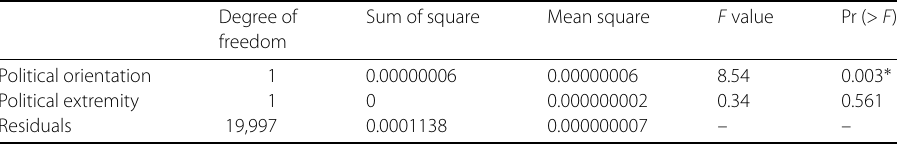
Table 19 Multi-group mean comparisons of obedience to authority using Tukey’s HSD test Mean 95% Confidence interval Adjusted difference P-valueLower Upper bound bound lwe-lw –0.0005 –0.0009 –0.0001 0.0051 ∗ rw-lw 0.0003 –0.0001 0.0007 0.18 rwe-lw 0.0012 0.0008 0.0016 <0.001 ∗∗∗ rw-lwe 0.0008 0.0004 0.0012 <0.001 ∗∗∗ rwe-lwe 0.0017 0.0013 0.0021 <0.001 ∗∗∗ rwe-rw 0.0009 0.0005 0.0013 <0.001 ∗∗∗